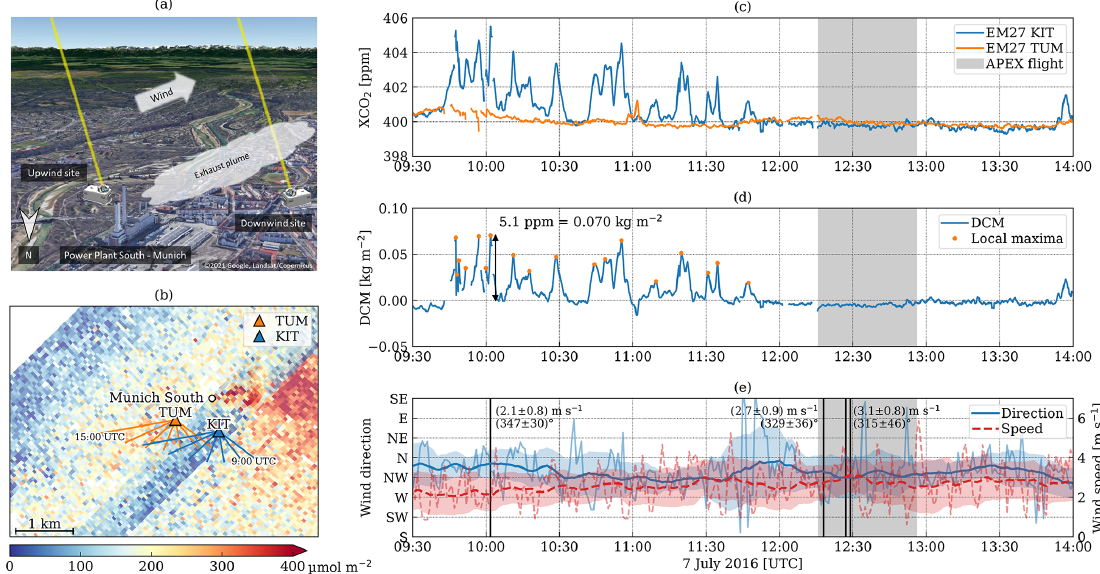
Figure 12. (a) The setup of the two FTIR spectrometers at Munich South. (b) APEX NO 2 map showing the NO 2 emission plume and the locations of the FTIR spectrometers. The lines are hourly lines of sight below 1100m above ground. (c) XCO 2 time series and (d) differential CO 2 measurements (DCM) for the two instruments. (e) Wind speed and direction measured every minute on the LMU rooftop at 30m above ground (thin lines). In addition, a 30min rolling average was applied to the time series (thick lines). The shaded area shows the 1 σ temporal variability within 30min. Vertical lines show times with the largest CO 2 peak and NO 2 measurements by the APEX instrument. The numbers are 30min mean wind speed and